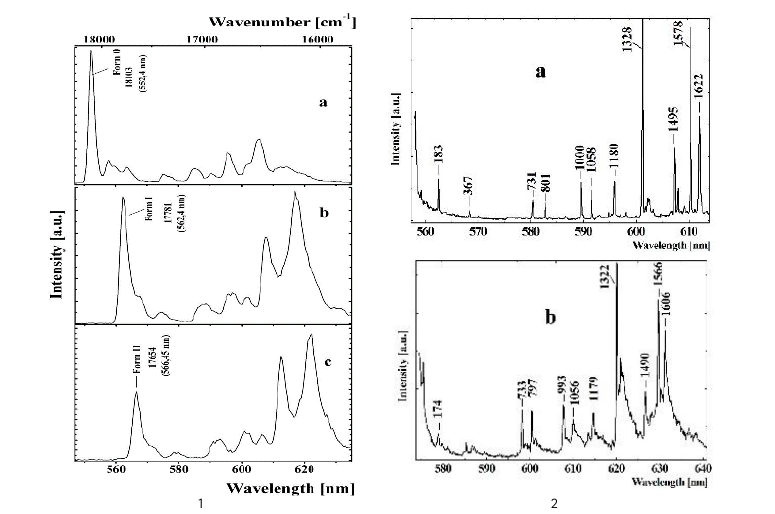
Fig. 1. Fluorescence spectra of ZnP (1) in solid argon matrix onto a sapphire substrate under nonselective excitation: λ exc. = 385(a), 388 (b), 404 nm (c) at T = 5 K and FLN spectra (2) of ZnP in n -octane, λ exc. = 556,8 nm (a) and ZnP in n -octane with pyridine λ exc. = 573,1 nm (b) at 4,2